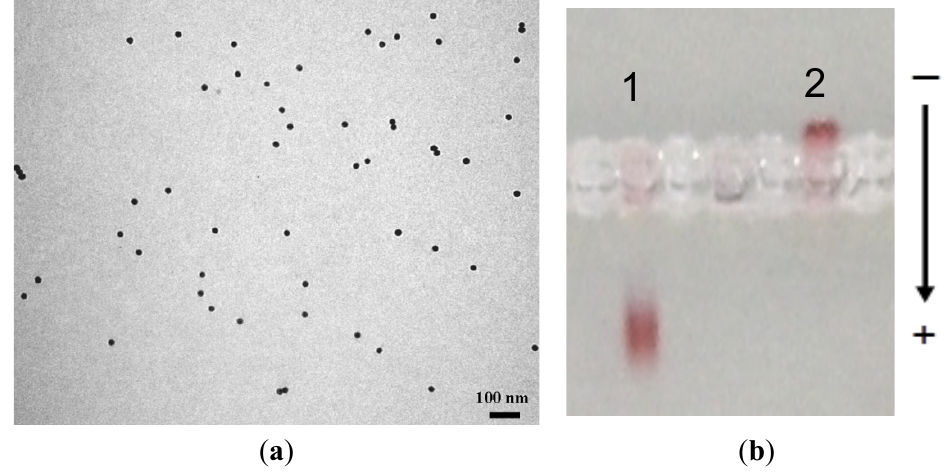
Figure 5. ( a ) TEM micrograph of the TAT-biotin gold conjugates and ( b ) agarose gel electrophoresis measurements of TAT gold bioconjugates, showing the mobilities of lane 1: streptavidin gold conjugates and lane 2: TAT peptide gold